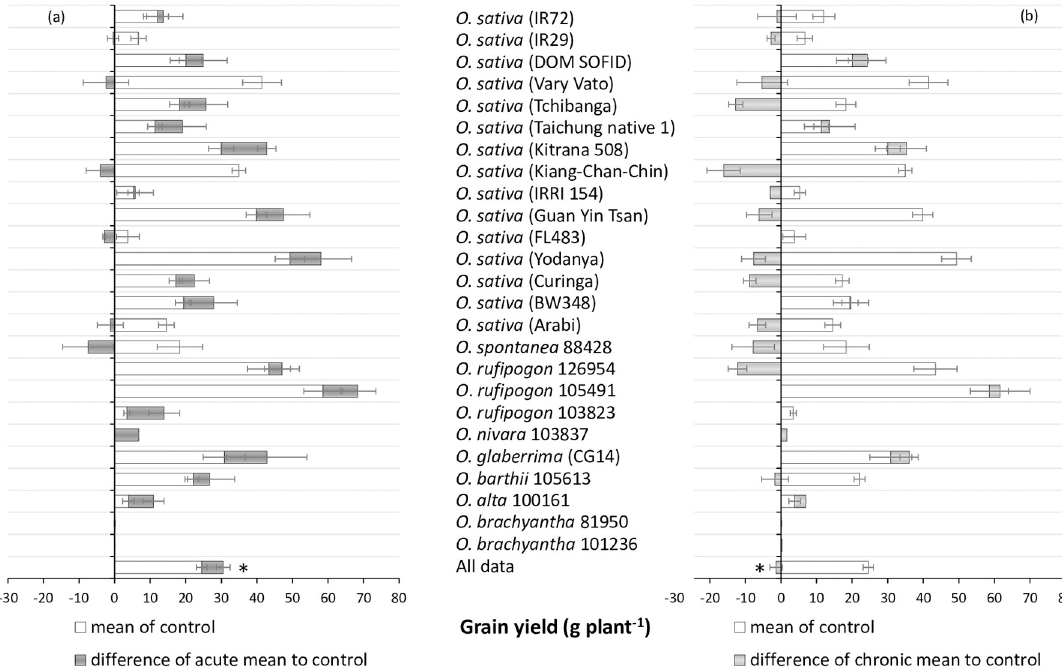
Fig 2. Grain yields of selected domesticated rice varieties and rice wild relatives in acute (a) and chronic (b) Fe toxicity stress compared to control conditions. The grey bars indicate the negative (directed towards the left) or positive (directed towards the right) difference from the control. Mean values and standard errors (n = 2–8) are plotted. Asterisk indicates a significant difference from the control at P < 0.05.